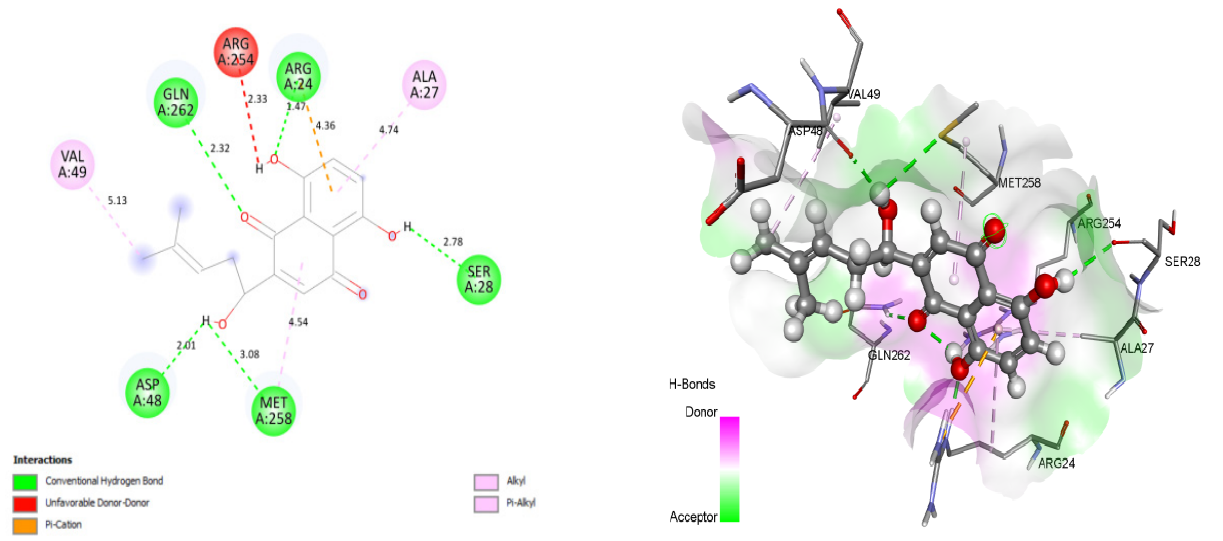
Figure 2. Docking view of Shikonin in the binding sites of PTP1B (PDB ID: 1AAX). On the left side is the stereo view of the docked complex-Shikonin and 1AAX, and on the right side are Shikonin-1AAX interactions presented in 2D. Diagrams are drawn in Discovery Studio, with hydrogenbonds shown as agreen dashed line. Protein structure residues are annotated with a 3-letter amino acid code, while Shikonin is presented in a ball-and-stick style.